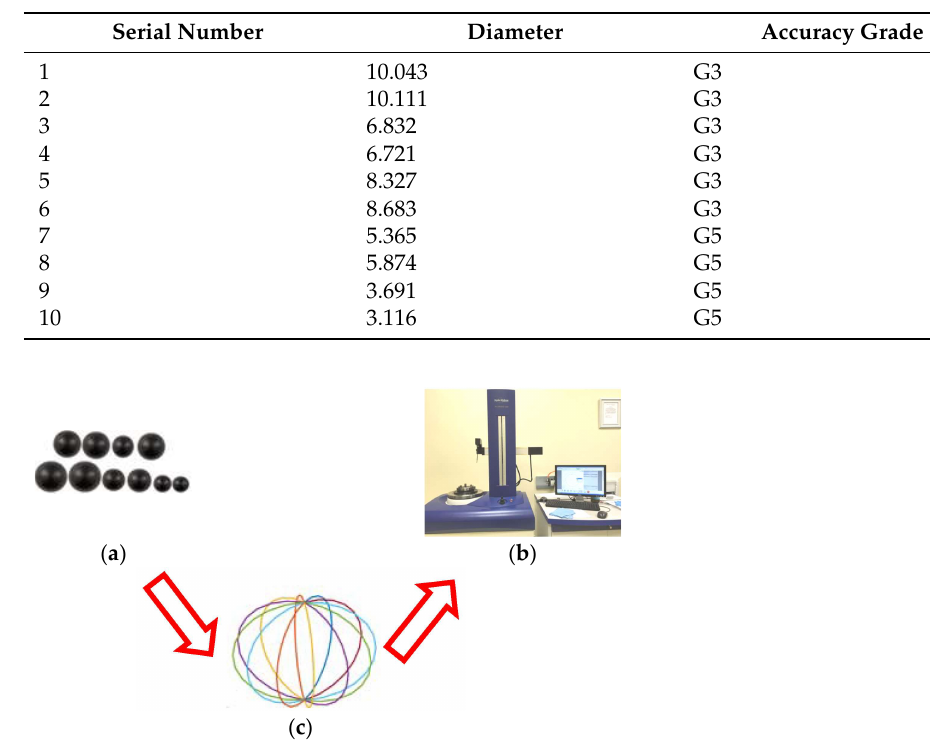
Table 2. Experimental sample specifications.